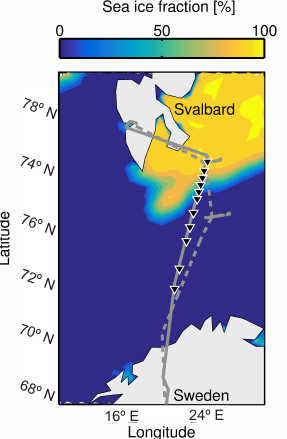
Figure 1. Flight track for B762 on 23 March 2013 over sea ice frac- tion (shading). Section 1 of the flight (grey, solid) was conducted at a high altitude, where 11 dropsondes (black triangles) were re- leased. Section 2 of the flight (grey, dashed) conducted straight, level runs over the sea ice and open water, with a sawtooth profile over the transition region.